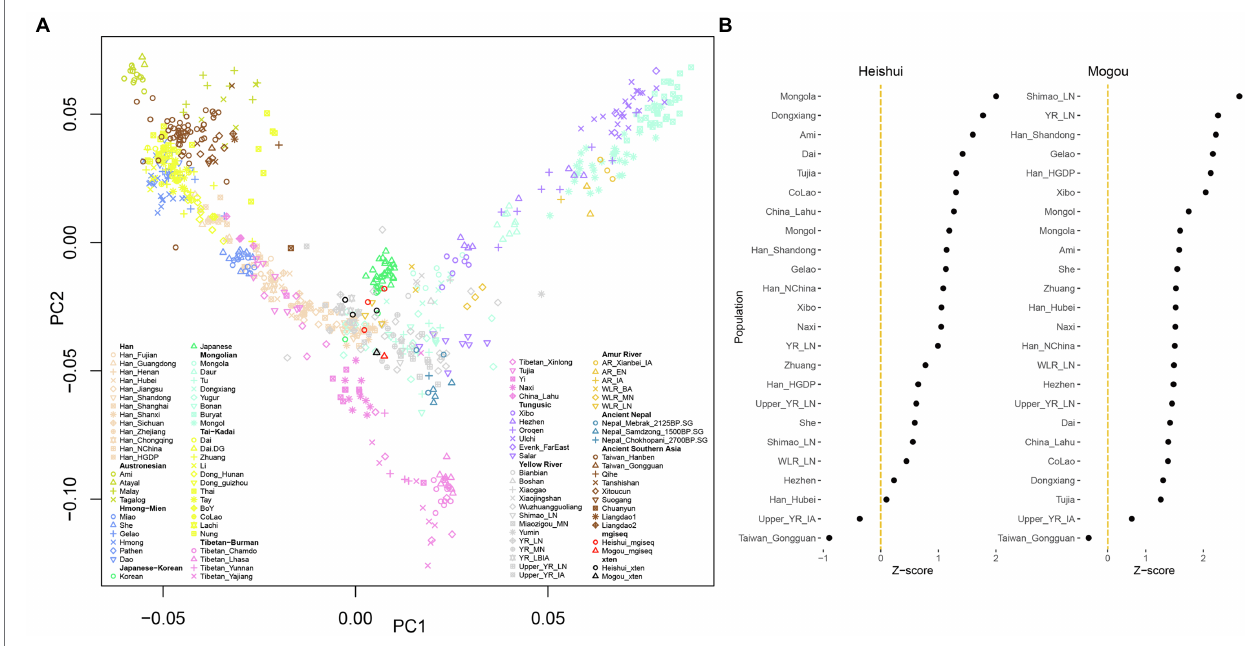
FIGURE 4 | Overview of population genetic structure. (A) Principal component analysis plot of present-day and ancient population in East Asia. The libraries sequenced by MGISEQ-2000 and Illumina X-Ten are colored by red and black, respectively. (B) f 4 -statistics measured the relationship between MGISEQ-2000 and Illumina X-Ten with various populations in the form of f 4 (Mbuti, X; MGISEQ-2000, Illumina